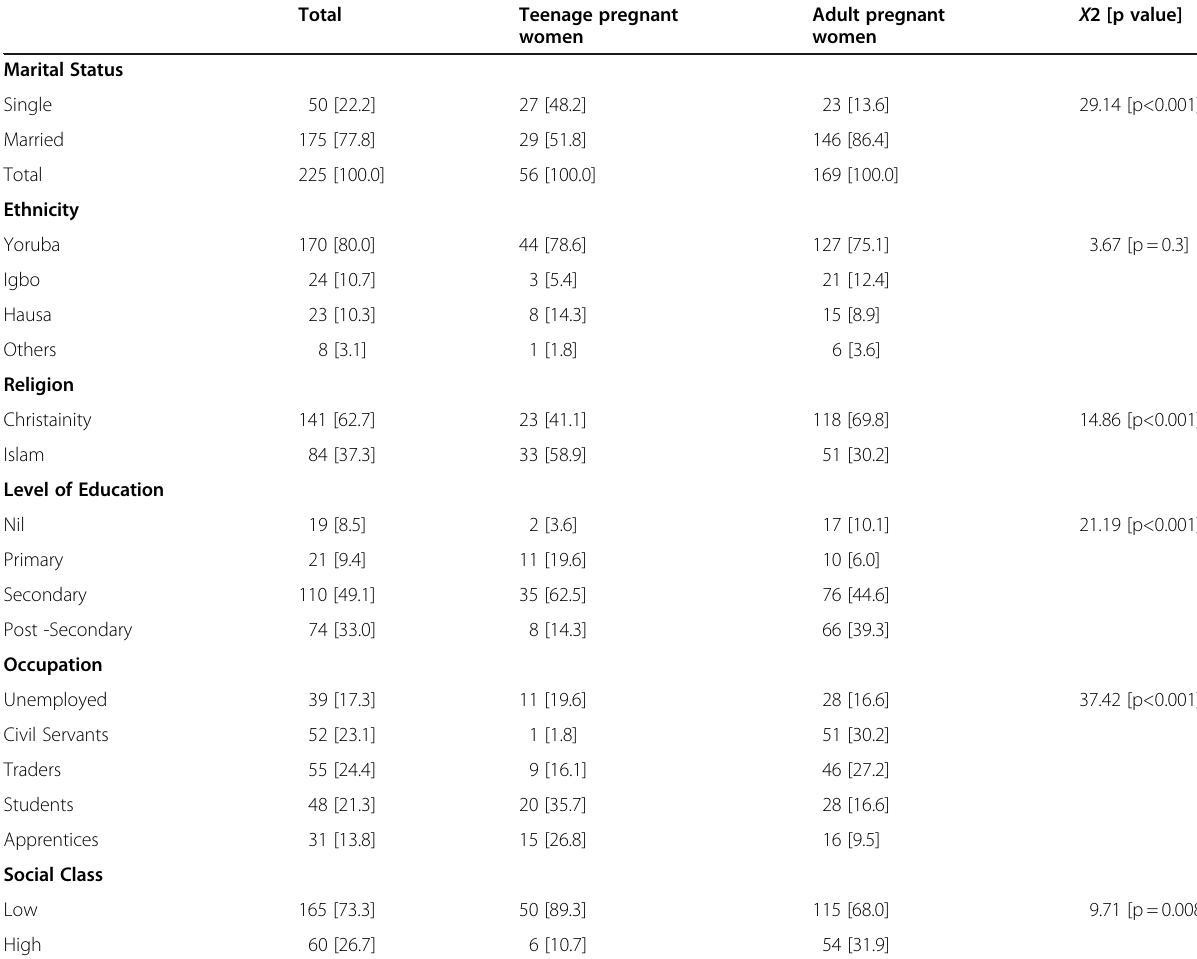
Table 1 Socio-dermographic Characteristics of the